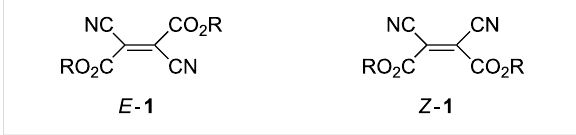
Figure 1: Dialkyl dicyanofumarates E - 1 and dicyanomaleates Z - 1 .